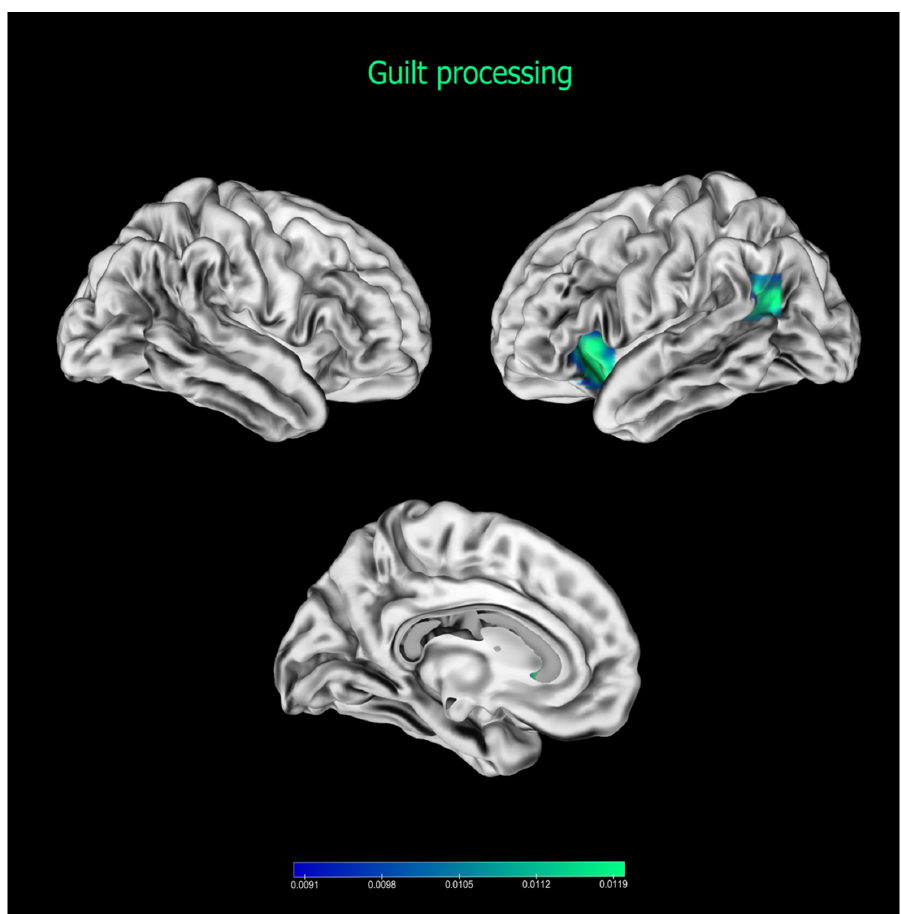
Figure 2. Results of the meta ‐ analysis on guilt neural correlates. Bars represent ALE